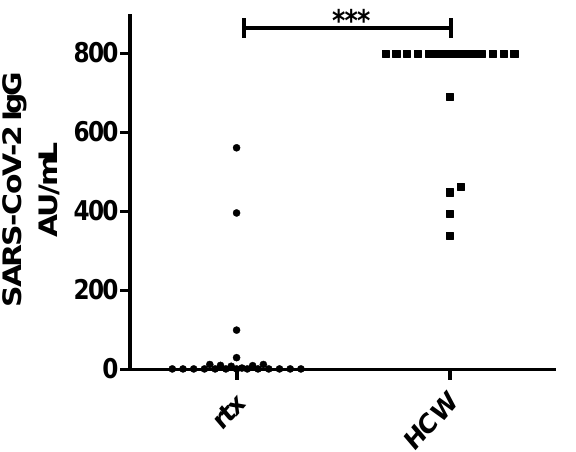
Figure 1. IgG Chemiluminescence Enzyme Immunoassays (CLIA) Arbitrary Units per milliliter (AU/mL) ratio in 23 renal transplant recipients (rtx) and 23 healthcare workers (HCW) after two doses of the mRNA-based SARS-CoV-2 vaccine BNT162b2. *** p < 0.0001. Table 1. Characteristics of patients after renal transplantation and healthcare workers after two doses of the mRNA-based SARS-CoV-2 vaccine BNT162b2. rtx renal transplant recipients; HCW, healthcare workers; n number; pos positive; neg negative; Ab antibody, CLIA Chemiluminescence Enzyme Immunoassays; AU Arbitrary Units; mL milliliter; Ab antibody. rtx HCW